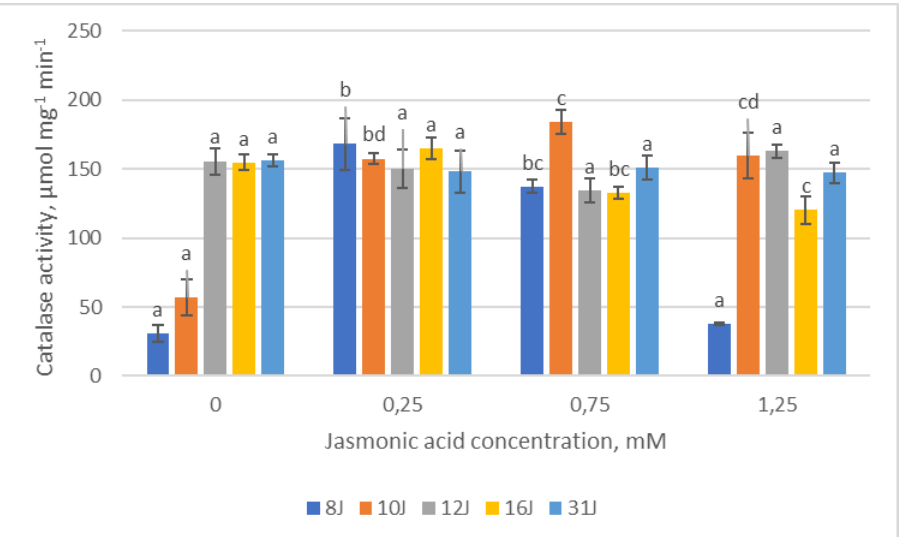
Figure 9. Means (µmol mg − 1 min − 1 ) ± SE of catalase (CAT) activity in five half-sib families of Scots pine, assessed 6 weeks after sowing. Data significance was calculated using the Kruskal–Wallis H test for ranks and post hoc Dunn’s test for pairs ( p < 0.05). Different letters next to different colors indicate significant differences between the groups, sprayed with different concentrations of jasmonic acid.